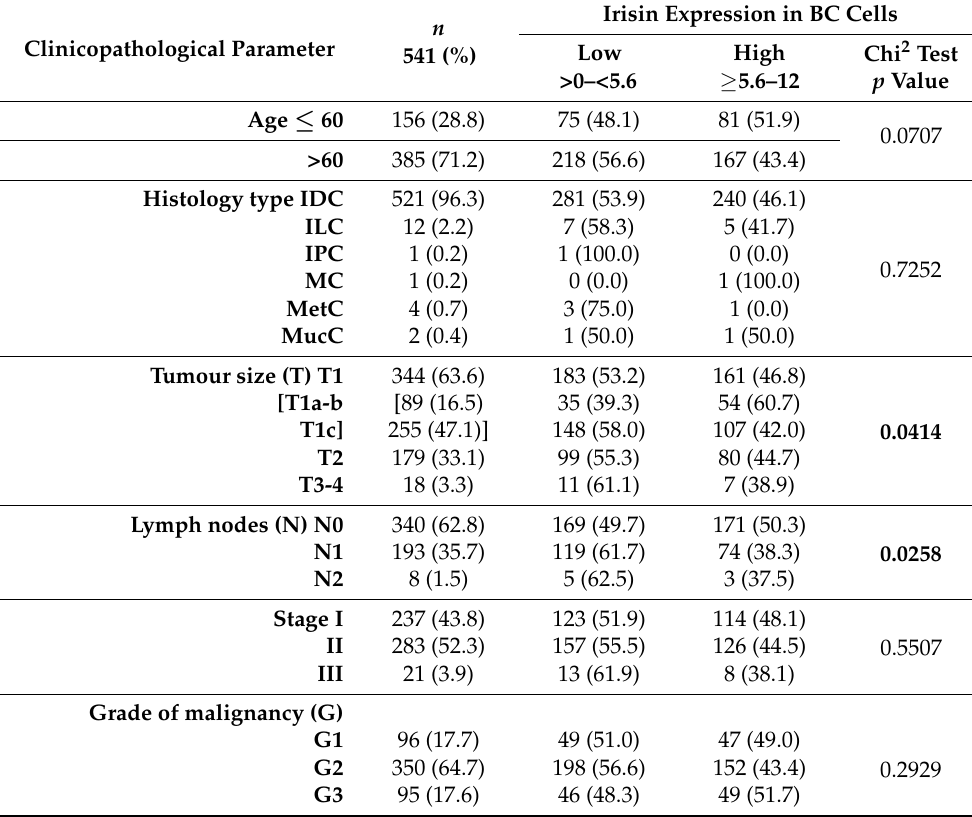
Table 1. Characteristics of BC patients related to low and high expression of irisin (divided according to the median value of 5.6) compared with chi-square tests.